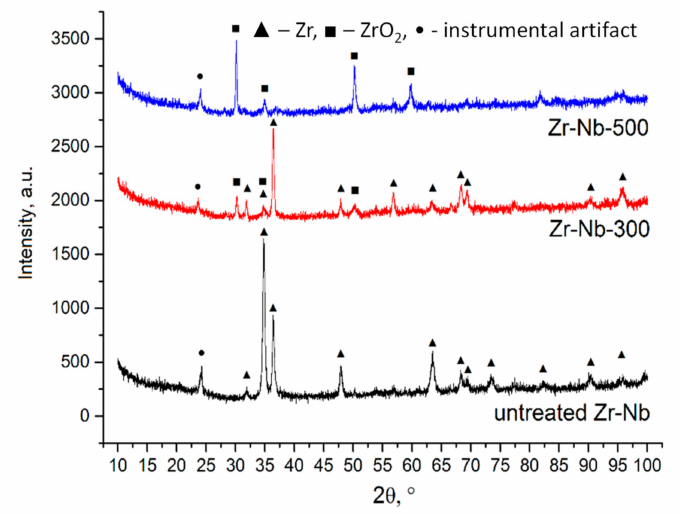
Figure 4. X-ray di ff raction patterns of ZrNb alloys with PEO coatings formed in the presence of Cu nanoparticles. For comparison, di ff ractograms have been stacked.